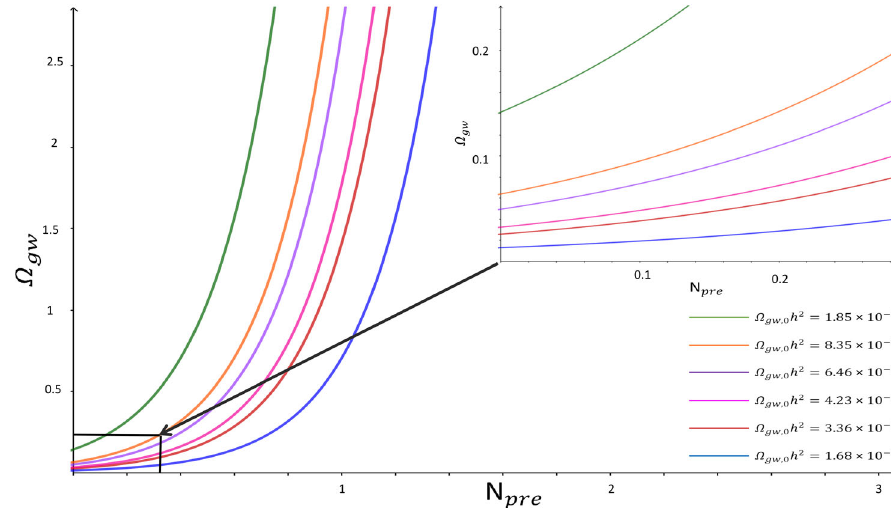
blue region represents Planck’s bounds on n s [2]. The black line corre- sponds to n = 1, the red line corresponds to n = 2, and the blue line corresponds to n = 3